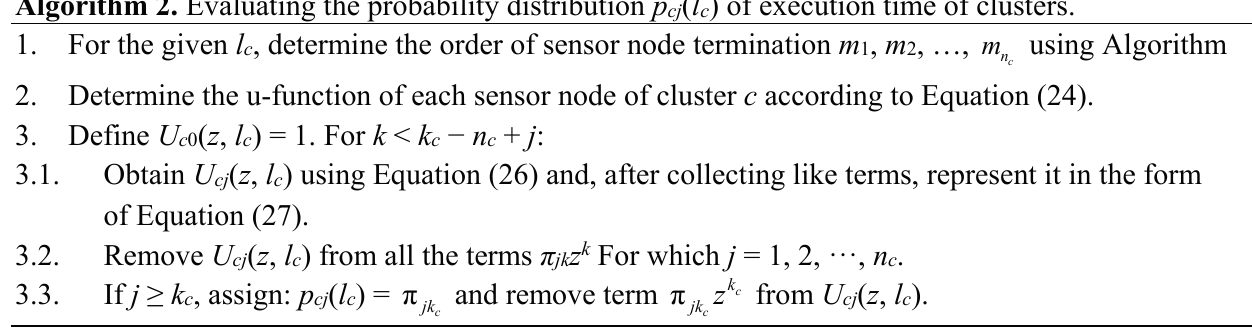
Algorithm 2. Evaluating the probability distribution p cj ( l c ) of execution time of